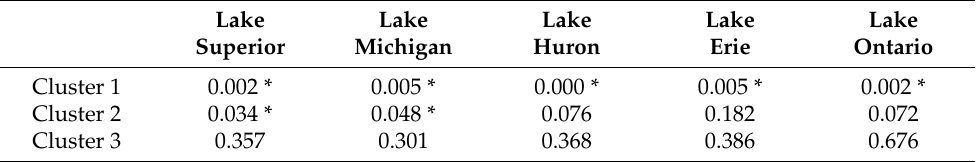
Table 6. Low-level (1000–850 mb) lapse rate permutation test p -values averaged across all reference longitudes. Starred values denote statistical significance ( p ≤ 0.05) between non-LES clusters and the LES